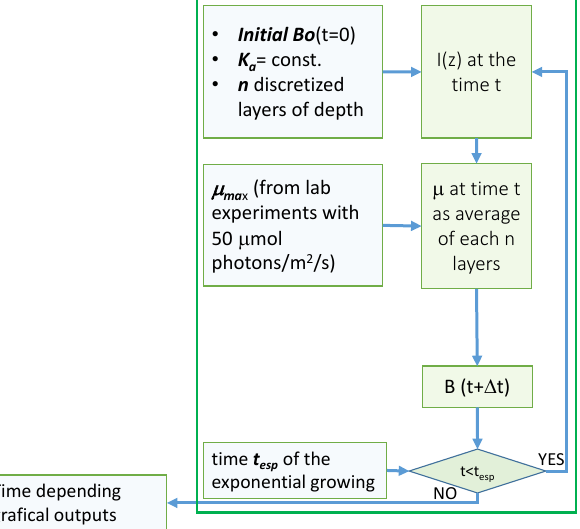
Fig. 4. Light-limitation and photo-inhibition kinetic model algorithm readapted from